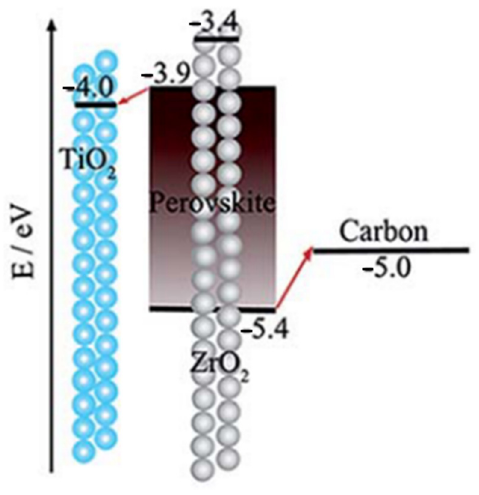
Figure 2. Energy level diagram of a typical mCPSC. Adopted from reference [16] with permission from The Royal Society of Chemistry.